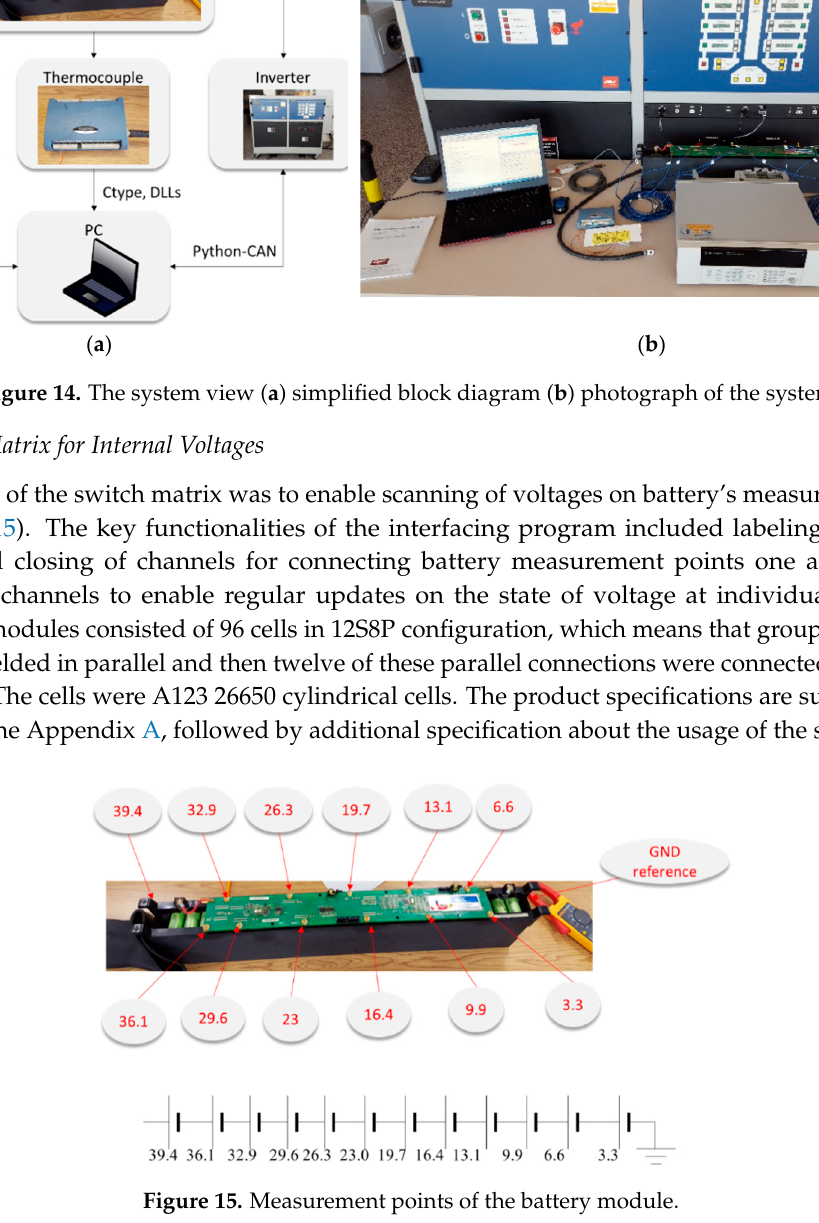
Figure 15. Measurement points of the battery module.